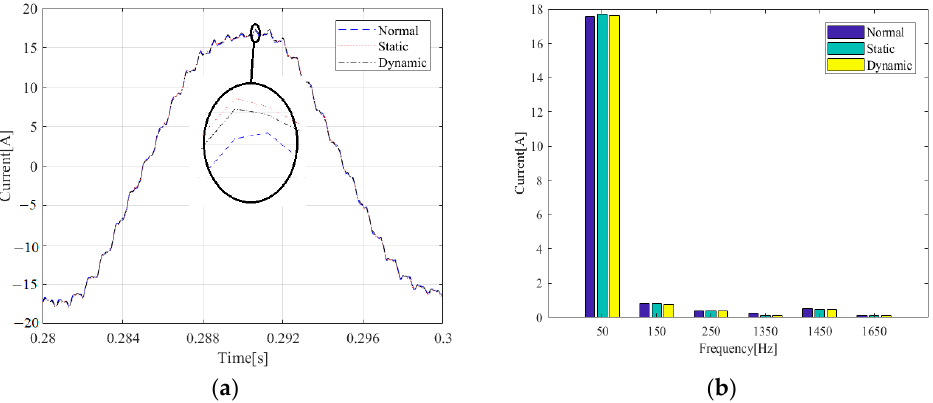
Figure 7. Comparison of current waveform and spectrum under three operating conditions: ( a ) current waveform; ( b ) current spectrum.